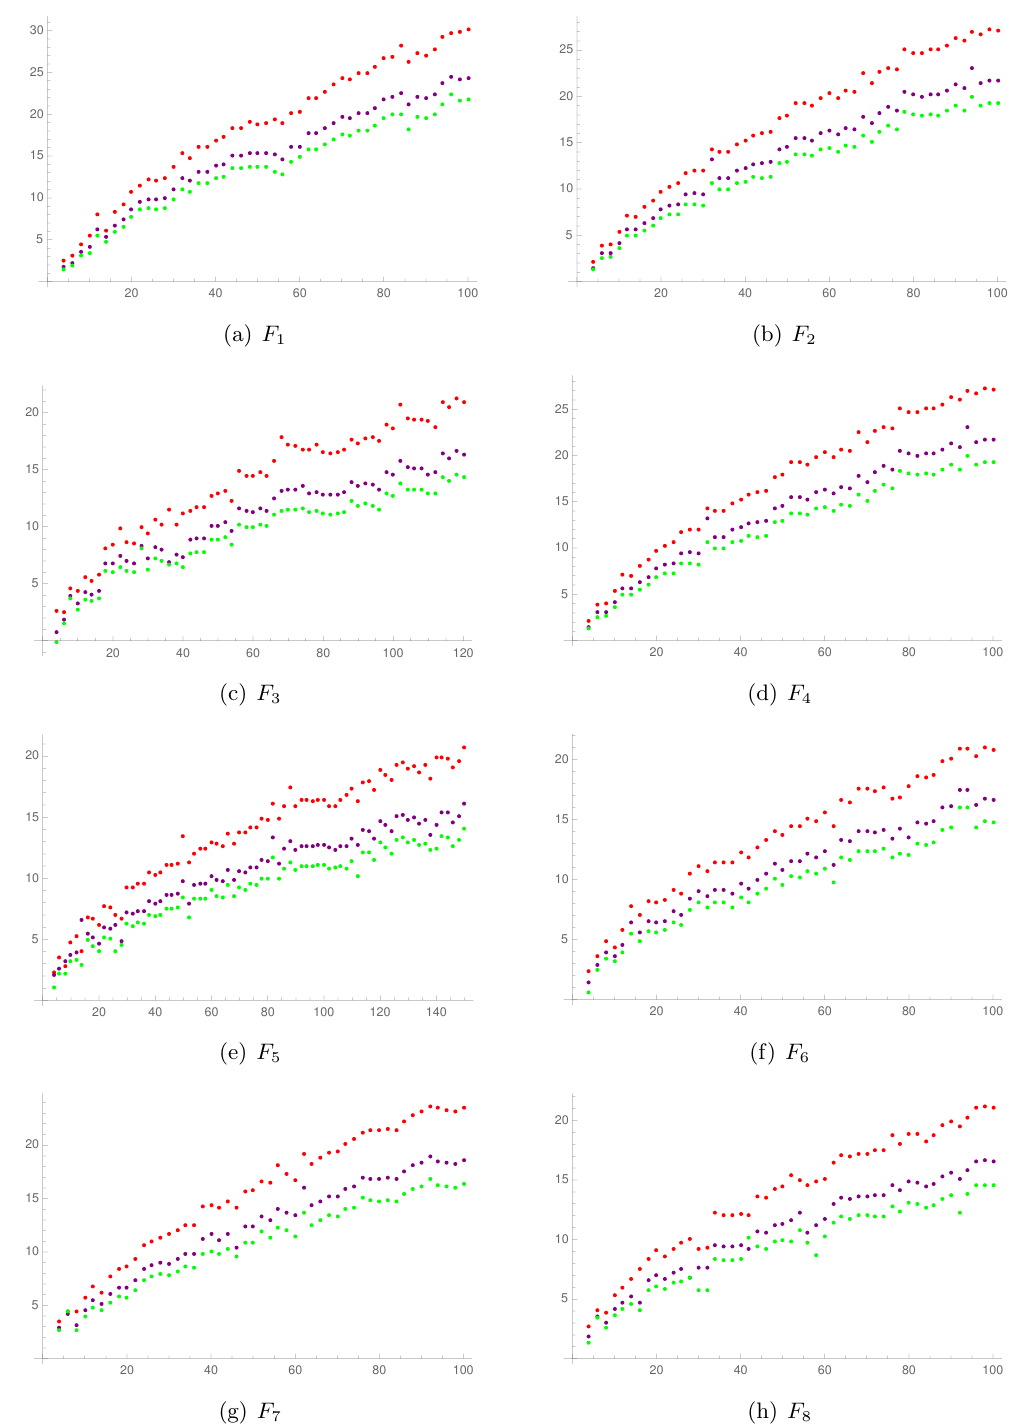
Figure 3 . Plots of numbers of identical digits (measured by matching degree de(cid:12)ned in (3.21)) between Borel-Pad(cid:19)e sums and numerical results against orders of perturbative series for F 1 ; : : : ; F 6 with ~ = (cid:25) (red), ~ = 11 (cid:25)= 7 (purple), and ~ = 2 (cid:25) (green). The increasing trend in these plots is a strong indication of the Borel summability of the spectrum.